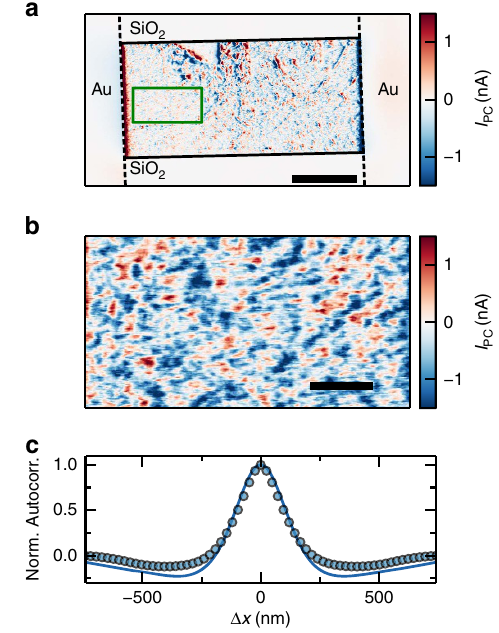
Figure 2 | Photocurrent profile at a grain boundary and its gate voltage dependence. ( a ) Photocurrent profile, measured at the black dashed line in